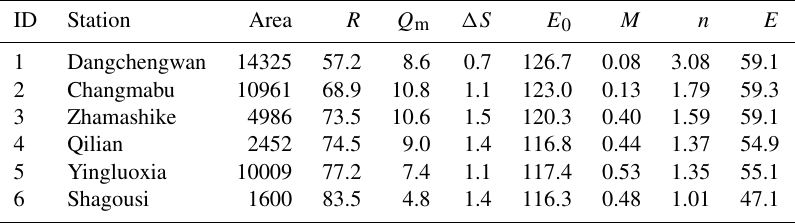
Table 1. Averaged monthly hydrometeorological characteristics and vegetation coverage in the growing season (2001–2014). ID Station